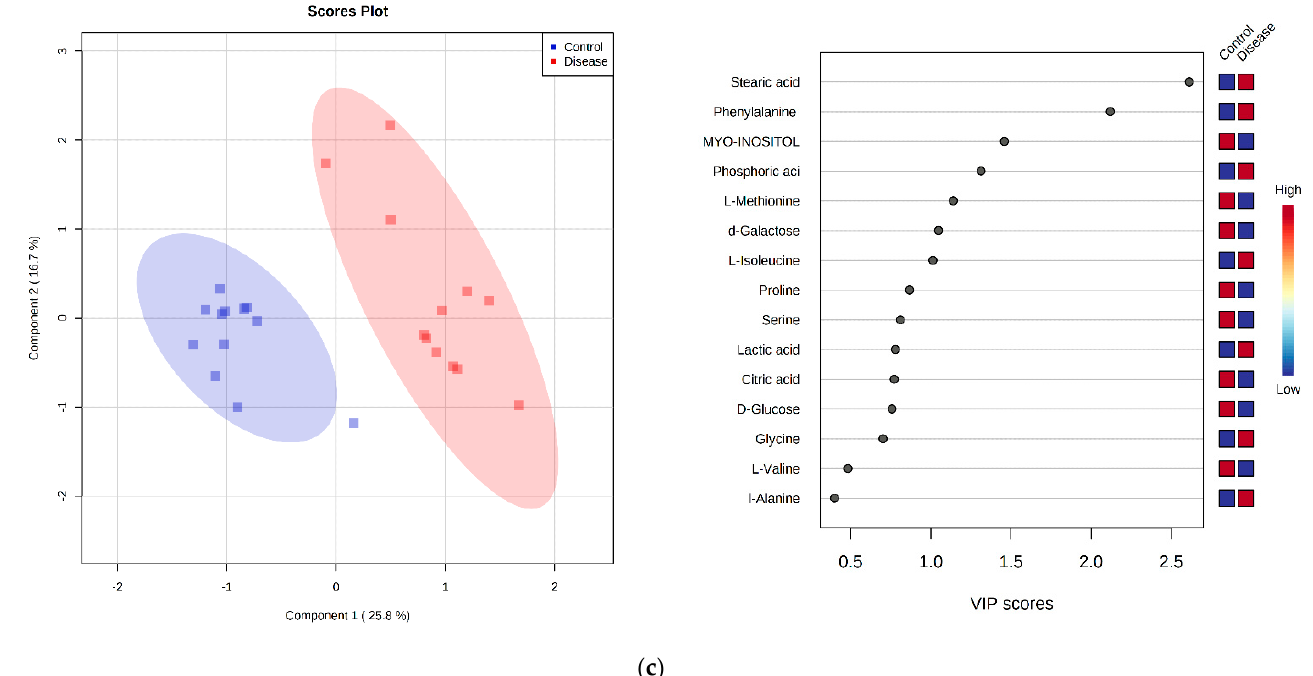
Figure 7. Partial least squares-discriminant analysis (PLS-DA) score plots were performed in 24 analyzed serum samples from control group and group of dogs infected with B. canis by untargeted LC-MS metabolomics analysis ( a ), targeted LC-MS metabolomics analysis ( b ), and GC-MS metabolomics analysis ( c ) (left panels). The list of the 15 important compounds/metabolites was identified by PLS-DA according to the variable importance on projection (VIP) score (right panels). The intensity of the colored boxes on the right represents the relative abundance of the corresponding metabolite in each group (blue-control, red-disease).